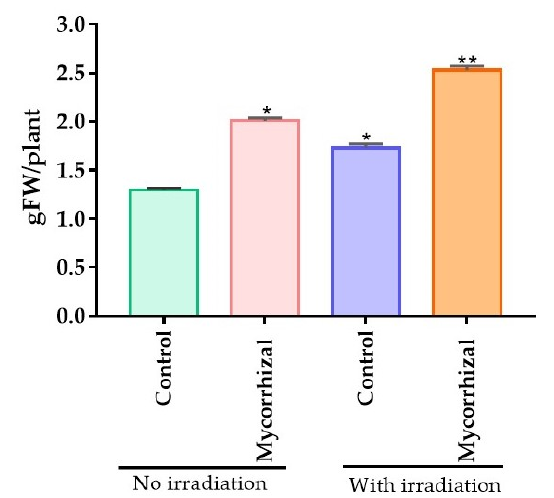
Figure 1. Impact of laser light and mycorrhizal co-treatment on plant biomass. Values are presented as mean ± SD whereas, * = p < 0.05, ** = p < 0.01. Table 2. Biological content of P. graveolens .